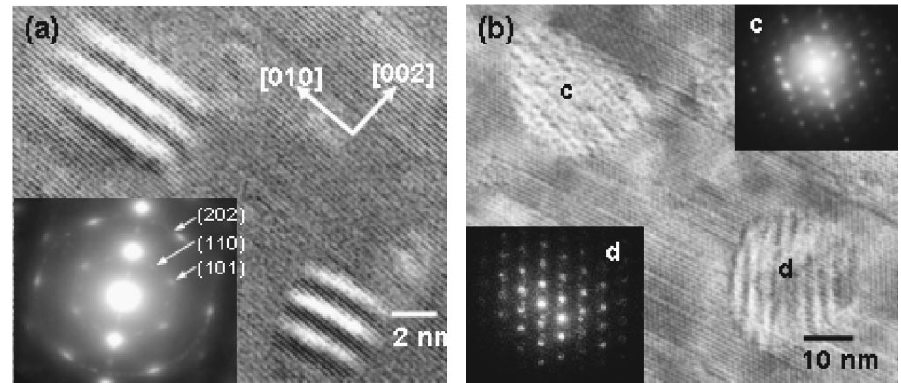
Figure 2. Identification of secondary phases in Mn-implanted GaN by high-resolution transmission electron micorscopy (HRTEM) imaging and selected area diffraction patterns (SADPs) annealed at: ( a ) 700 ◦ C with the identified Mn 3 Ga phase, and ( b ) 900 ◦ C with the phases identified as Mn 6 N 2.58 ( c ) and Mn 3 N 2 ( d ), respectively. Reproduced with permission from Reference